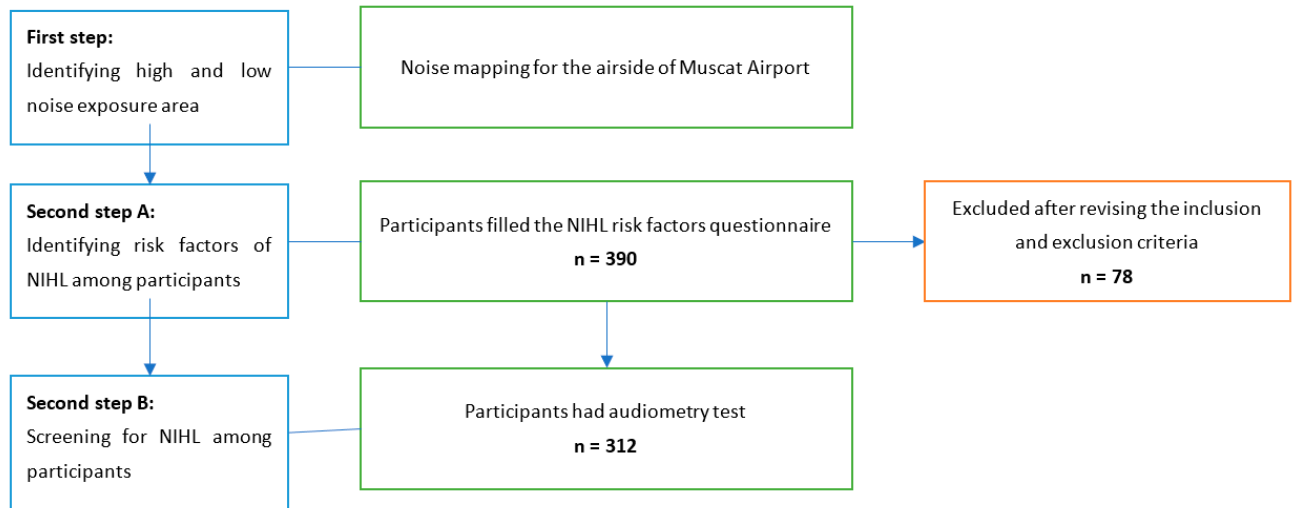
Figure 1. Flow chart showing the two steps that were carried out in this study. The total number of participants was 390, however, we only included n = 312 in the analysis, as seen in the diagram.